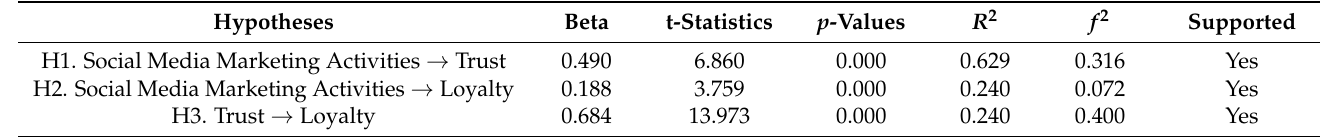
Table 4. Structural